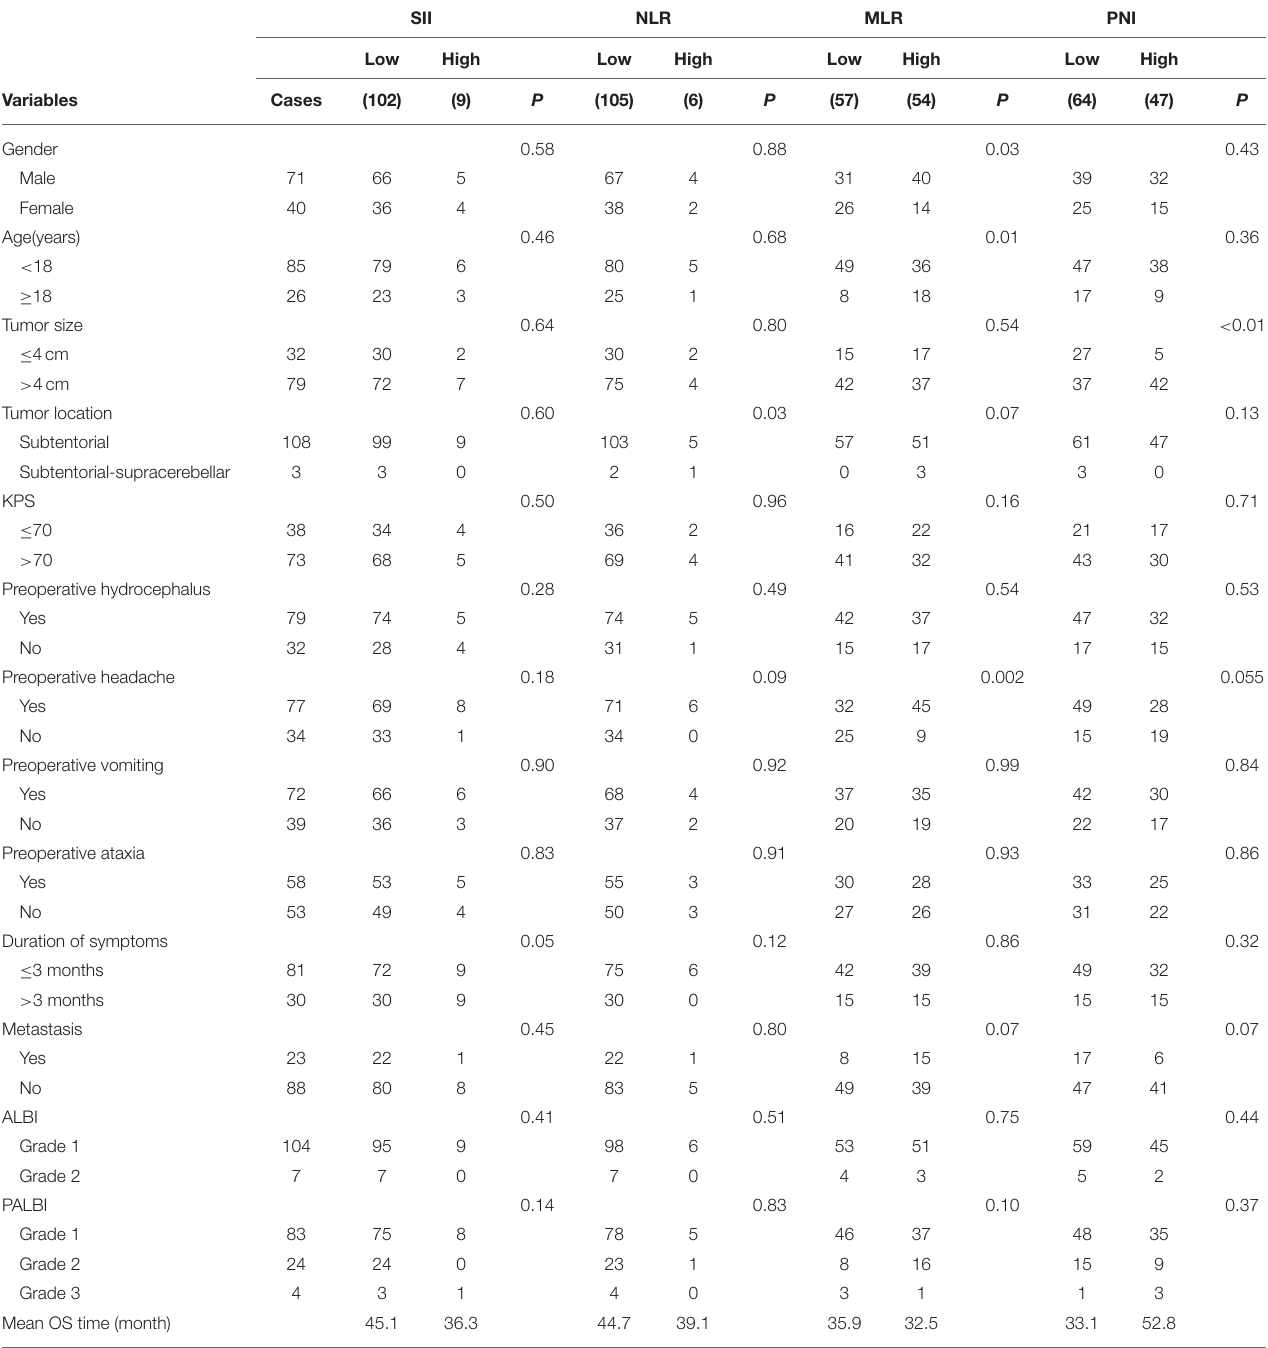
TABLE 1 | Baseline patient and disease